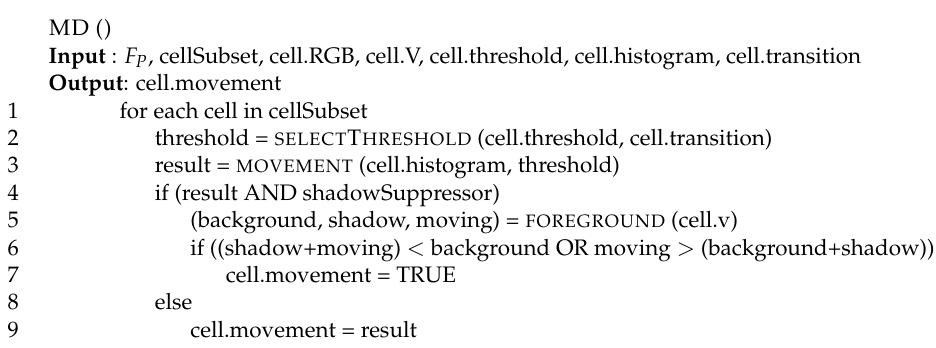
Figure 9. Checking for movement: function MOVEMENT DETECTOR